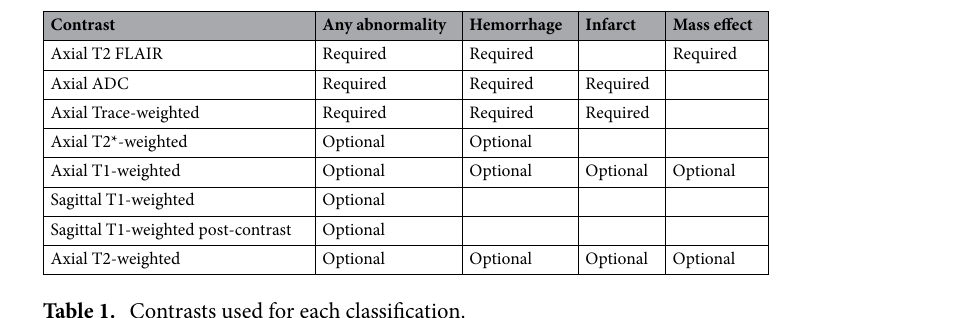
Table 1. Contrasts used for each